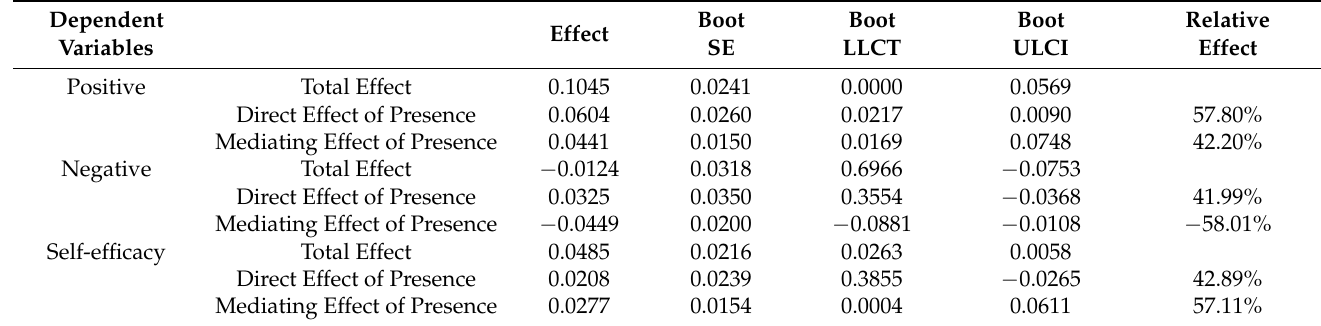
Table 1. Analysis of the mediating effect of presence.